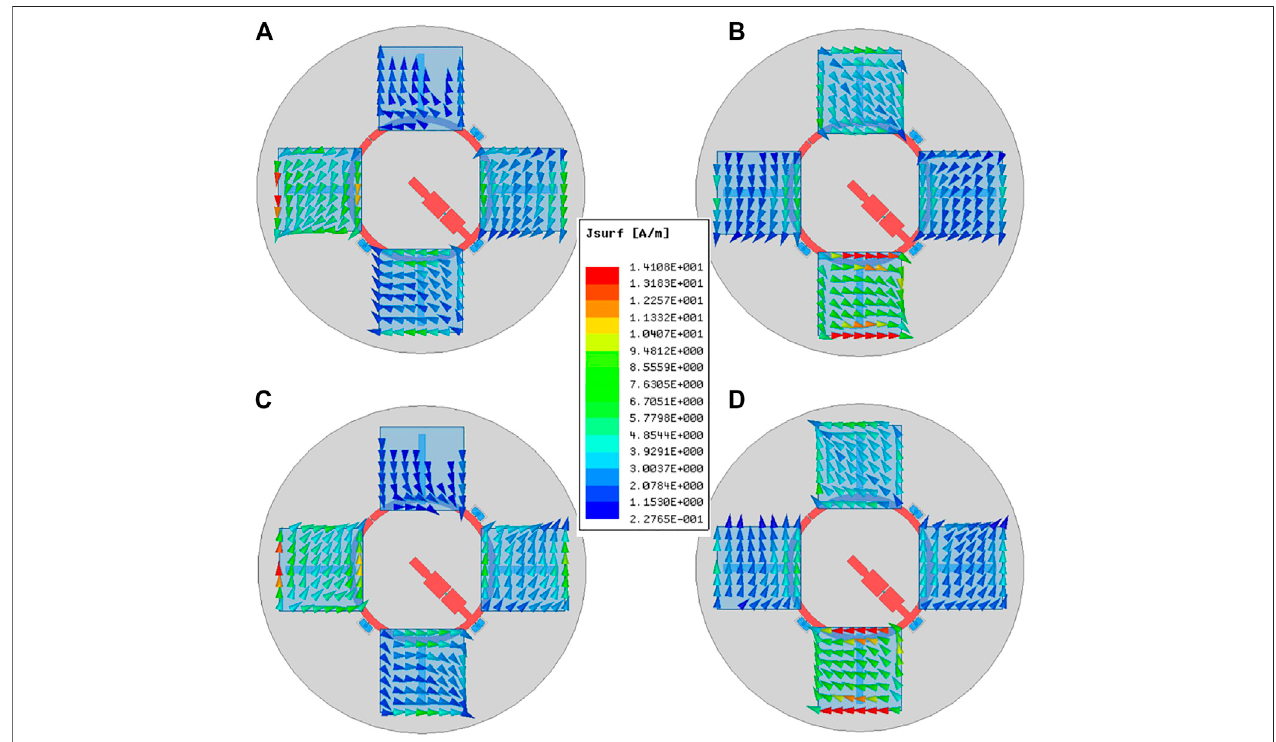
FIGURE 3 | Simulated current distribution on the patches over a period of time when SW1 is ON and SW2 is OFF: (A) t (cid:1) 0; (B) t (cid:1) T/4; (C) t (cid:1) T/2; (D) t (cid:1) 3T/4.